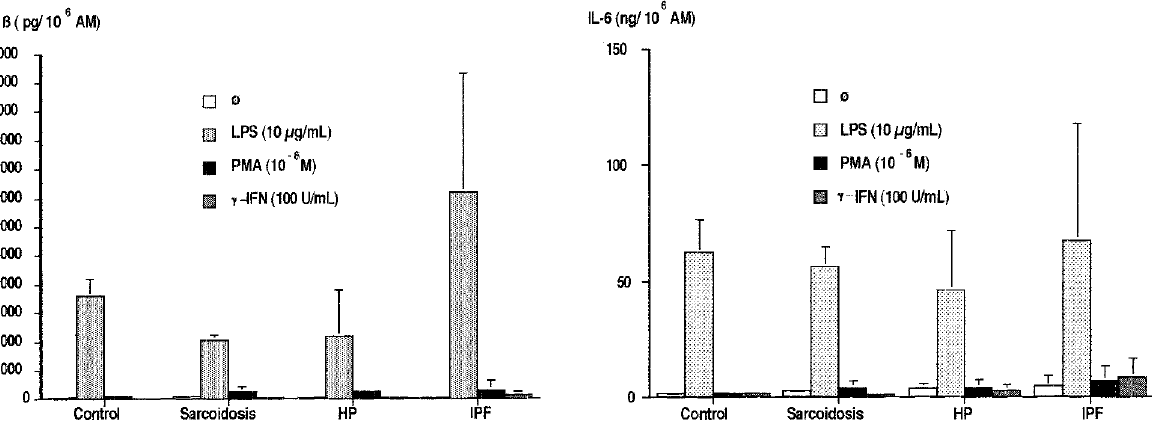
FIG. 2. Interleukin-1 b secretion in the different experimental groups. Statistical study of the effect of the different stimuli on IL-1 b secretion by AMs revealed significant differences (Wilcoxon test) between basal secretion and that stimulated by LPS ( P <0.001) or by phorbolmyristate ( P =0.001). No significant differences were observed between basal secre- tion and that elicited by interferon. On comparing LPS- induced secretion with that induced by PMA, the existence of statistically significant differences was observed (Wilcoxon test, P =0.001). Comparison among the different groups did not reveal significant differences under either basal or stimulated conditions. Definition of abbreviations: